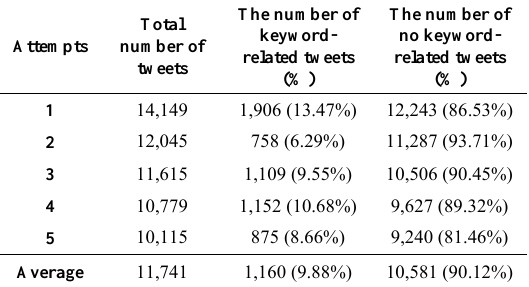
Table 1. Data gathering results from seed analysis algorithm